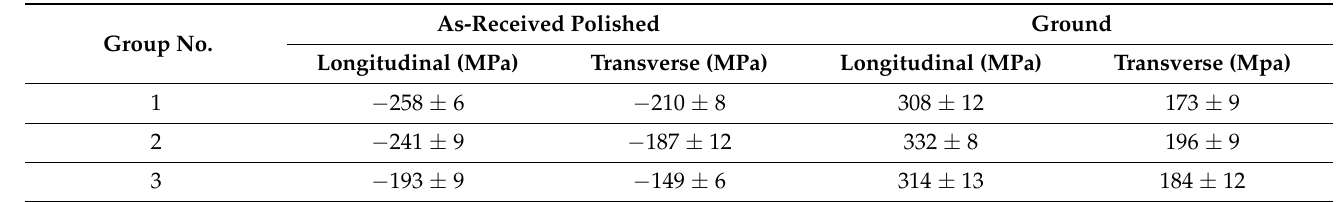
Table 3. Residual stress magnitude measured with X-ray diffraction method for L-PBF 316L specimens in various groups.